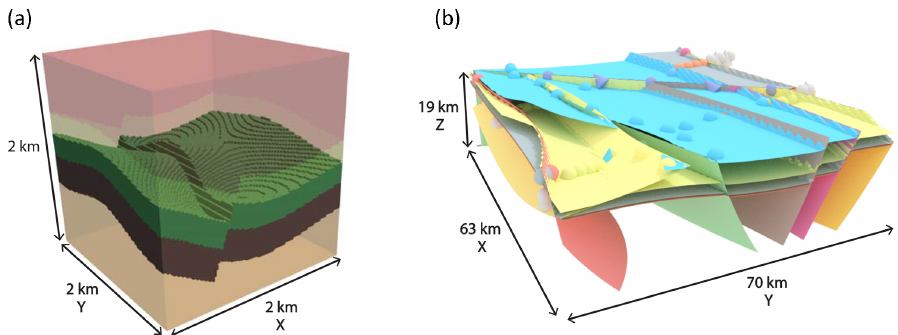
Figure 1. Example of models generated using GemPy . (a) Synthetic model representing a reservoir trap, visualized in Paraview (Stamm, 2017); (b) Geological model of the Perth basin (Australia) rendered using GemPy on the in-built Python in Blender (see Appendix F for more details), spheres and cones represent the input